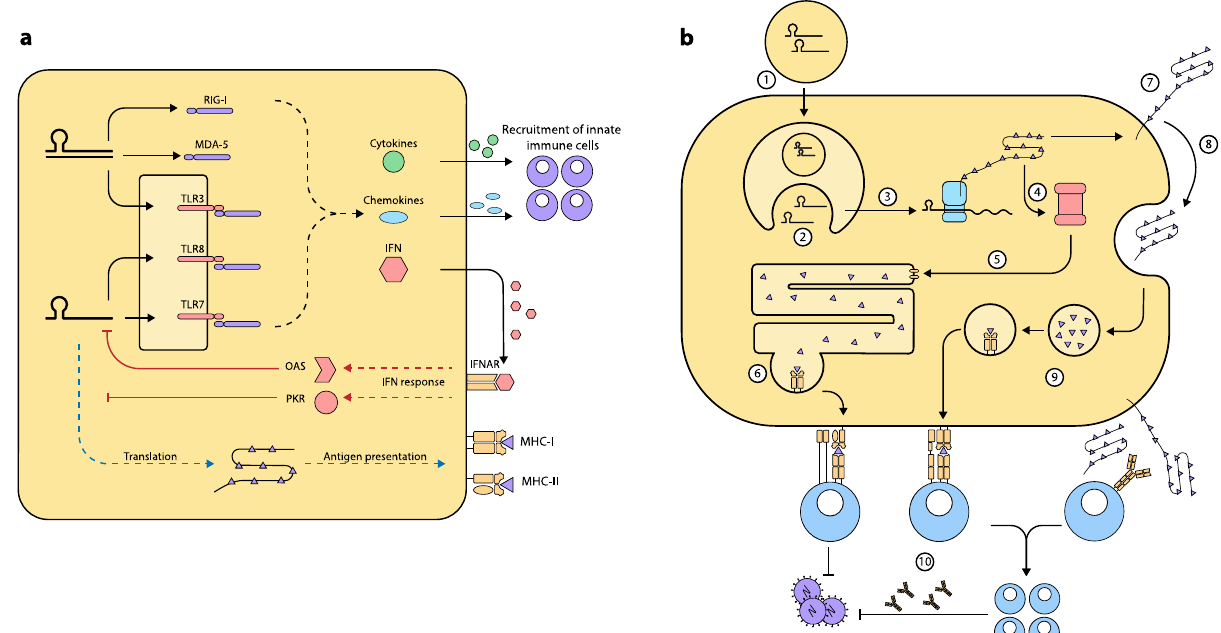
Fig. 3 Immune response to mRNA vaccines. a Innate Immune response to mRNA vaccines The delivery of the mRNA molecules into the cytosol is followed by the detection of the mRNA molecules by TLRs. Double-stranded RNA molecules co-delivered as impurities or produced from SAM or as secondary structures are additionally detected by RLRs (RIG-1, MDA-5). These drive cytokine and chemokine responses that recruit more innate cells to the injection site. Ampli fi ed interferon response can result in the activation of OAS/PKR whose signals impede translation, protein expression and antigen presentation. b Adaptive Immune response to mRNA vaccines. Following In vivo delivery of the mRNA vaccine, the mRNA molecules with the delivery vehicles are (1) uptaken by cells such as DCs at the site of injection by endocytosis